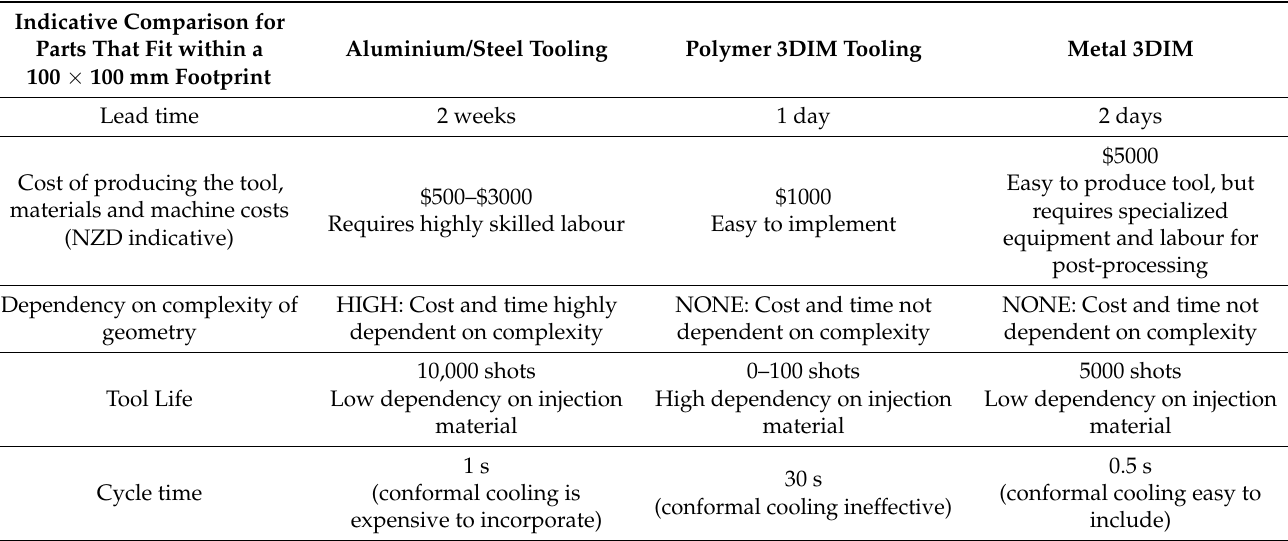
Table 9. Tooling comparison.